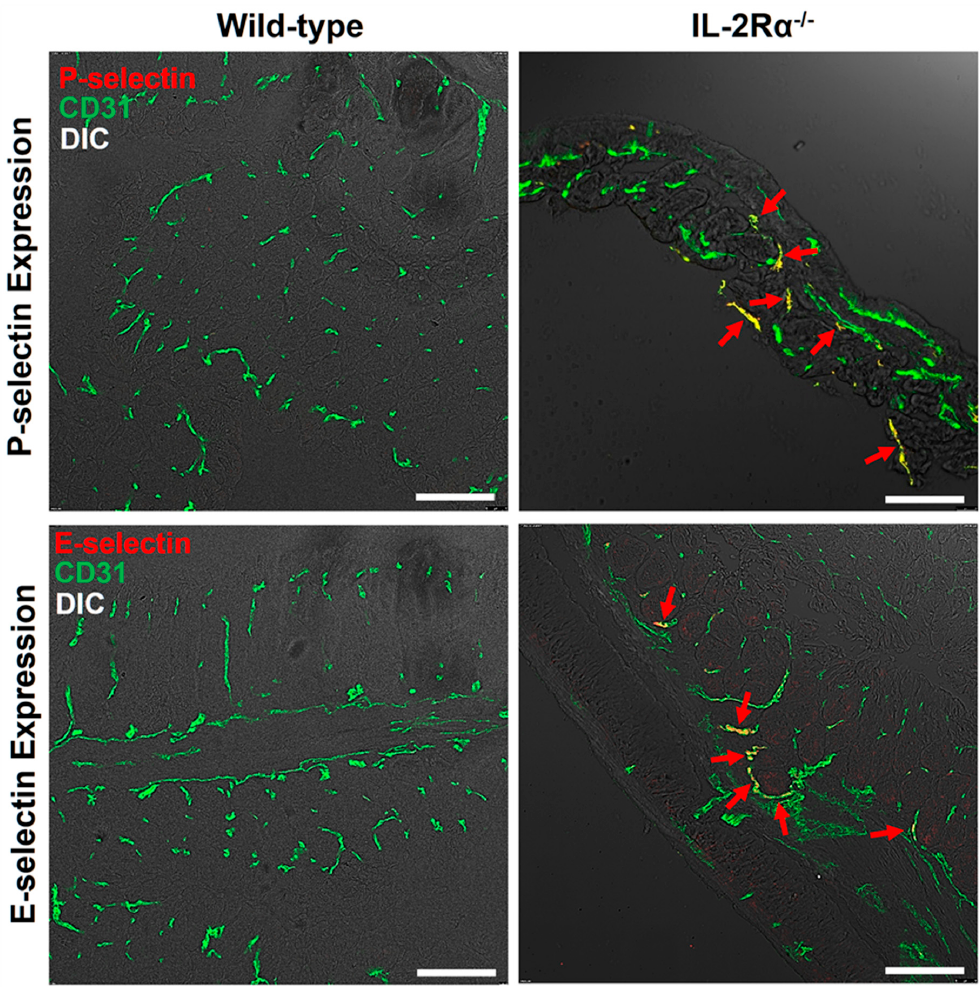
Figure 6. P- and E-selectin expression of colon from representative IL-2R α -/- and wild-type mice. Representative wild-type mice ( left column ) showed background expression of P-selectin ( top row ) and E-selectin ( bottom row ) in the colon. Representative IL-2R α -/- mice ( right column ) demonstrated strong expression ( red arrows ) of P-selectin ( top row ; highlighted in red) and E-selectin ( bottom row ; highlighted in red) on CD31-positive vascular endothelial cells (highlighted in green) in the inflamed colon. Confocal micrographs were overlaid on differential interference contrast (DIC) images. Scale bars, 100 μ m.